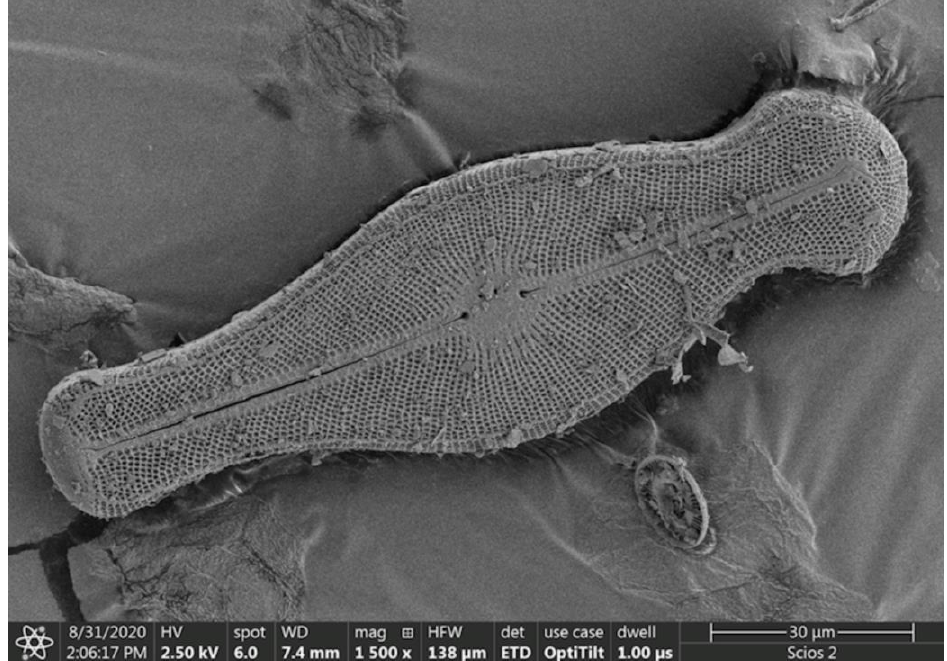
Figure 1. SEM image of Didymosphenia geminata (valve view).